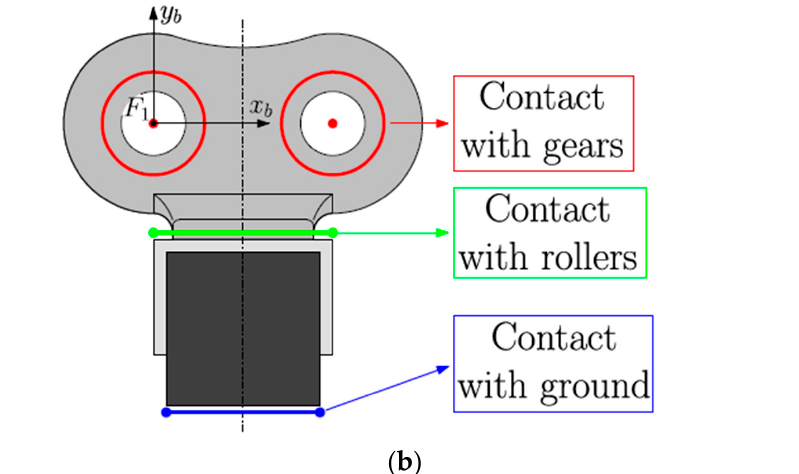
Figure 11. Links of the chain that constitutes the track belt: ( a ) outer and inner links, ( b ) contact surfaces.